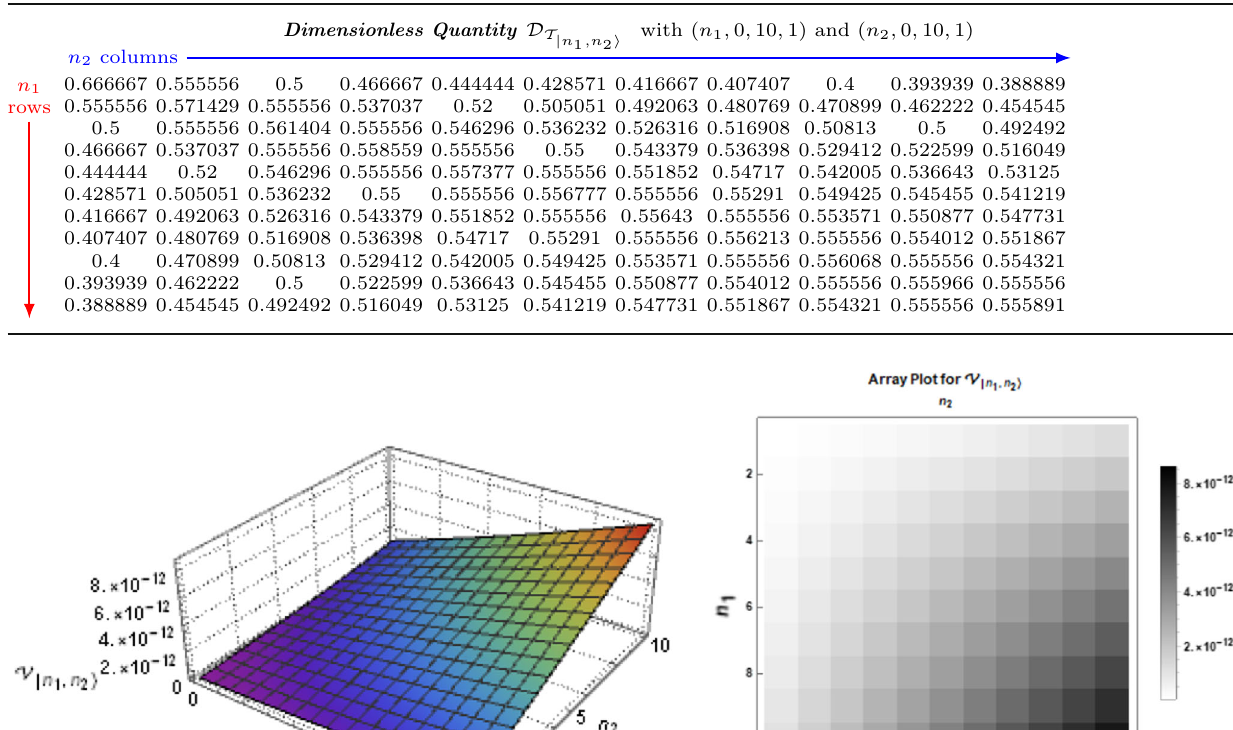
Table 2 Numerical values of D T with the associated parameters of number particles states n 1 and n 2